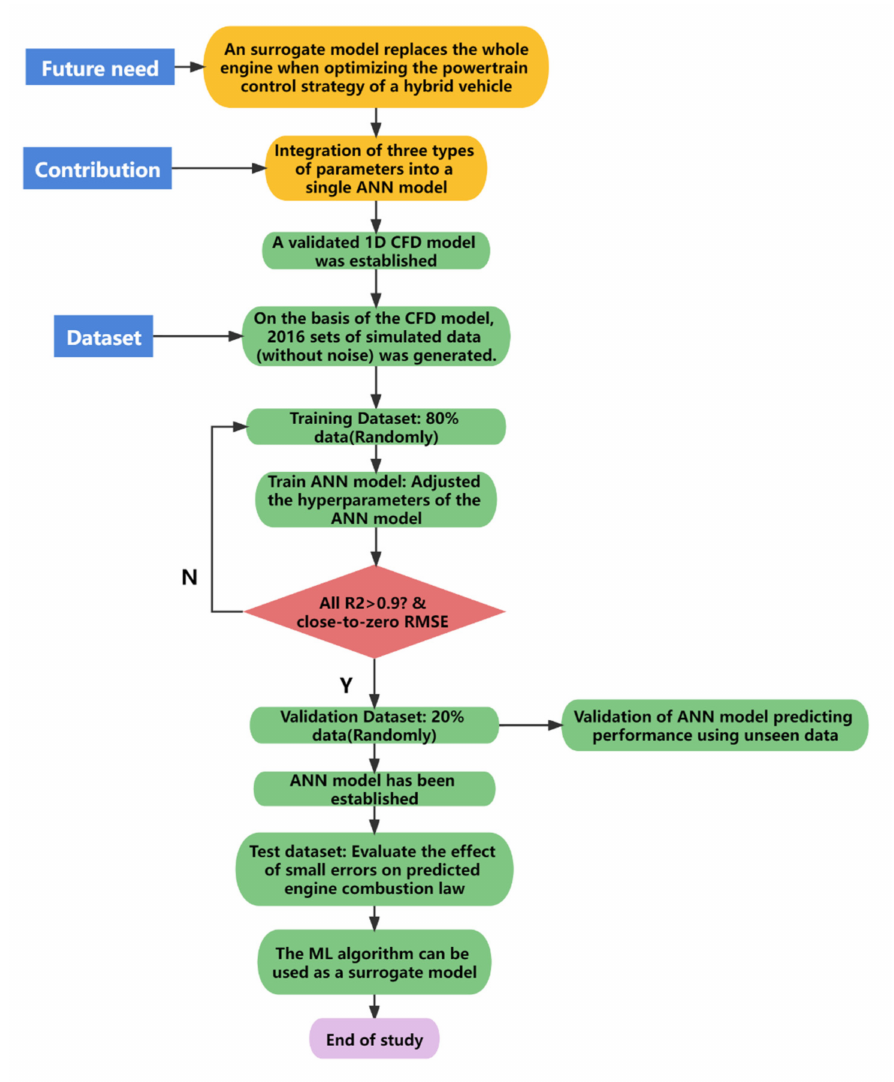
Figure 2. The overall flow chart of the